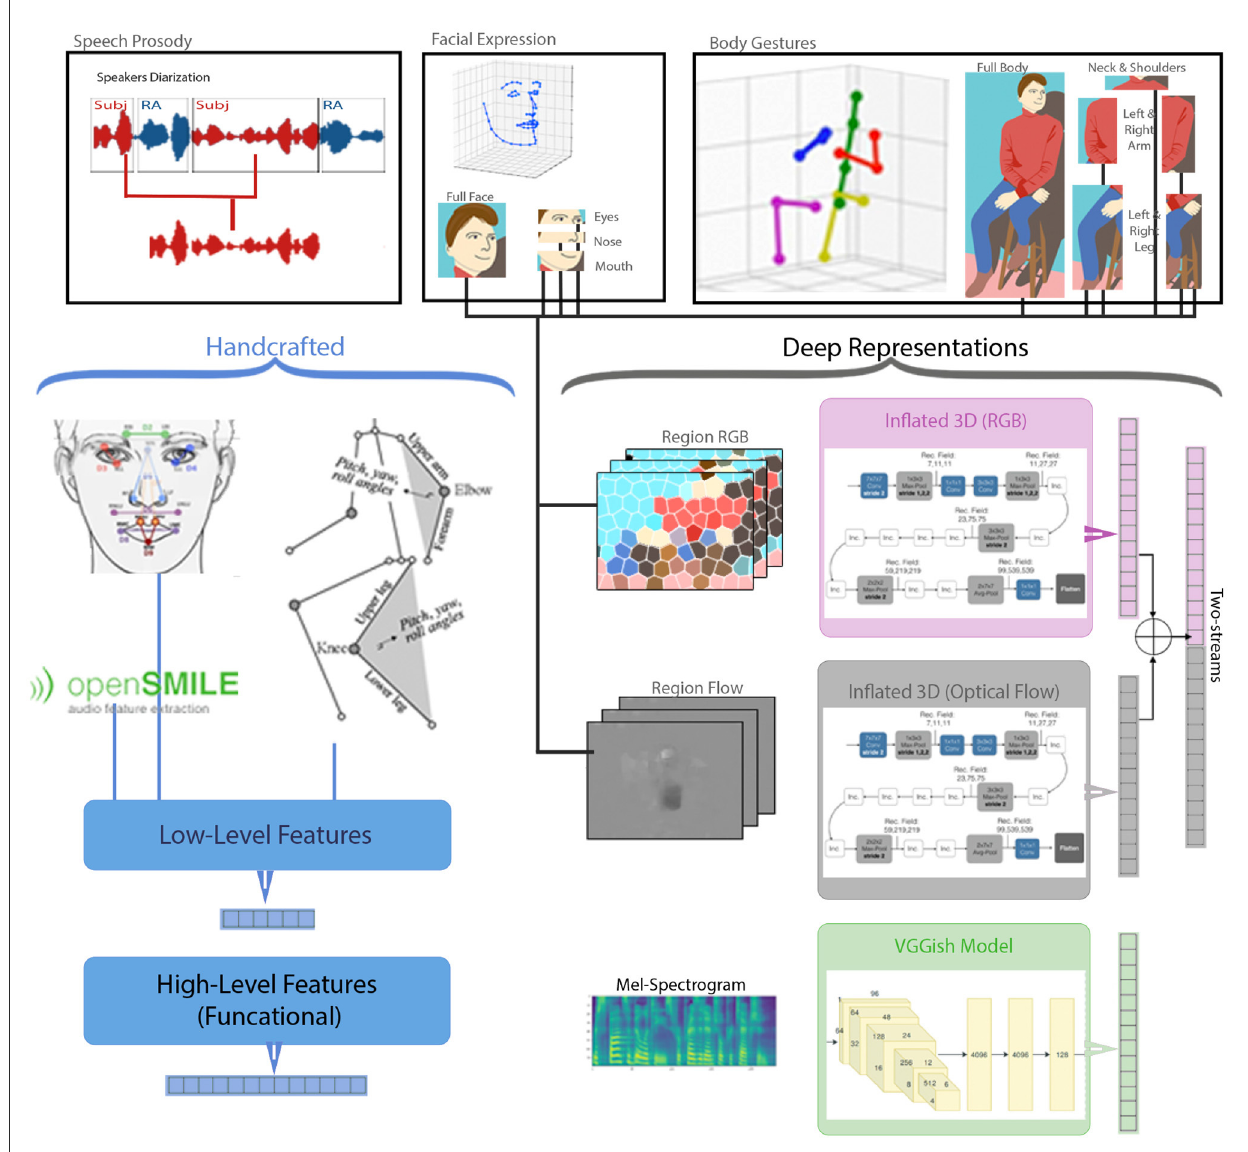
FIGURE1 Behavior feature extraction from speech acoustic, facial expression, and body gestures. [Showing (1) the pre-processing steps of: speaker diarization, 3D facial landmarks, and 3D body joints, (2) handcrafted acoustic and region-based nonverbal behavior extraction forming low-level and high-level feature vectors, and (3) deep representation extraction of region-based RGB, Flow, and Two-streams, as well as audio